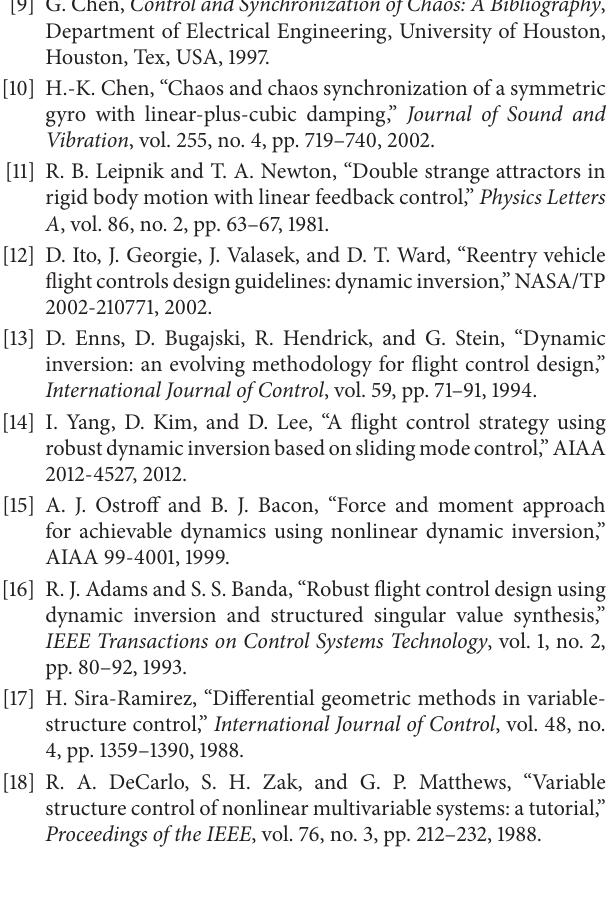
̇𝜃 Figure 10: Simulation results of and error trajectories of synchronized chaotic gyros: (a) trajectories of ̇𝜃 error behavior of